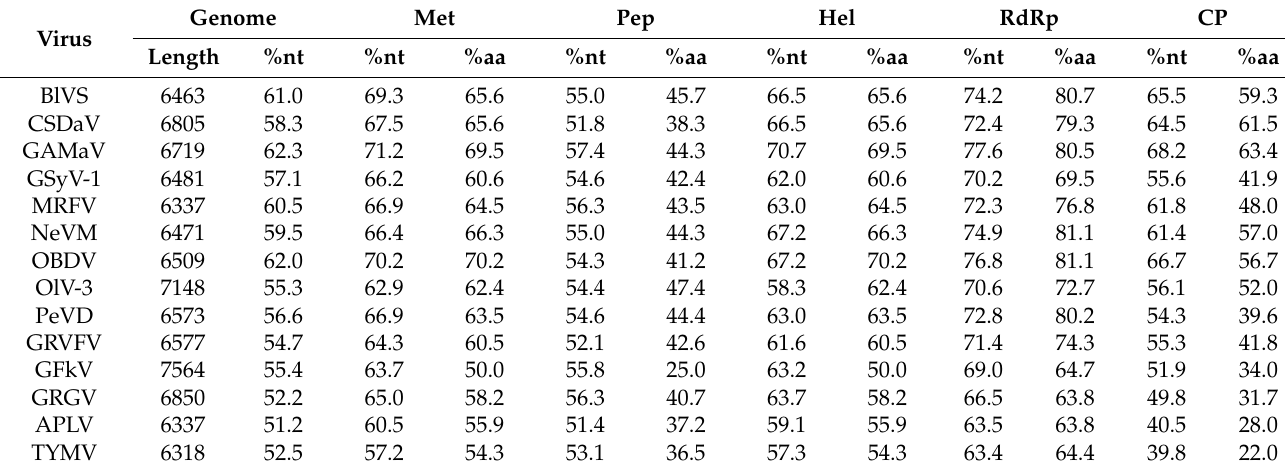
Table 1. Percentage identities for different polyprotein domains of representative viruses compared with grapevine- associated marafivirus